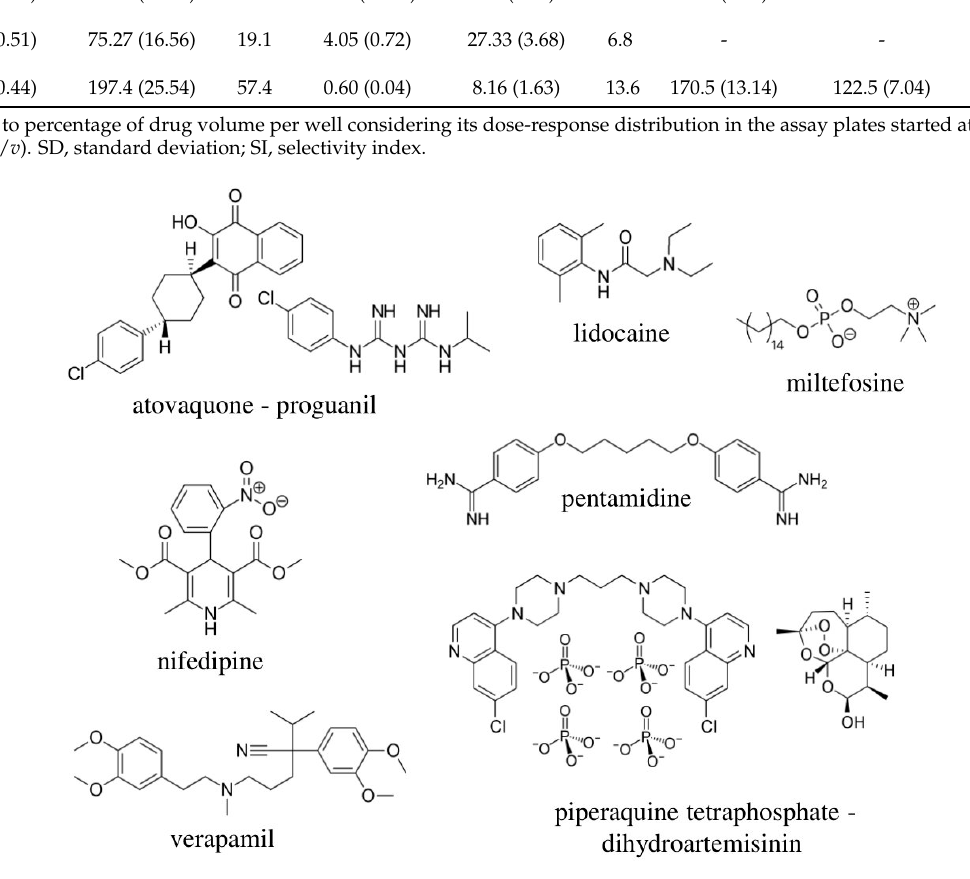
Figure 2. Chemical structures of the seven active drugs identified in the anti-parasitic assay based on Vero cells as hosts.